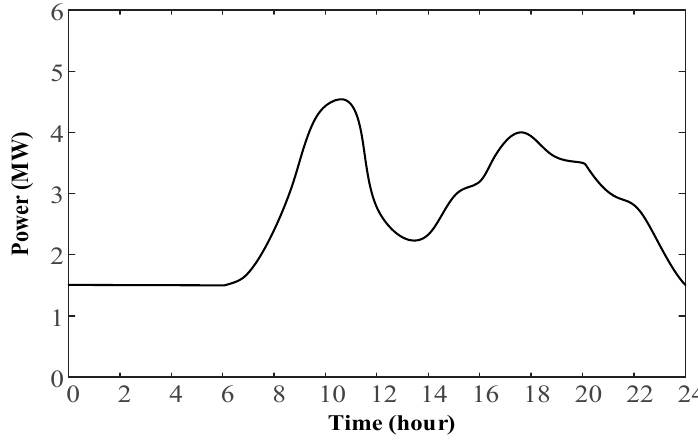
Figure 3. The average yearly load curve of the proposed community.